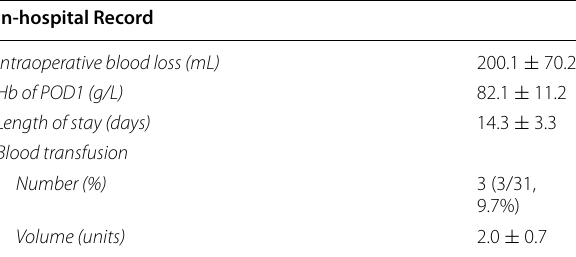
Table 2 In-hospital record of patient underwent